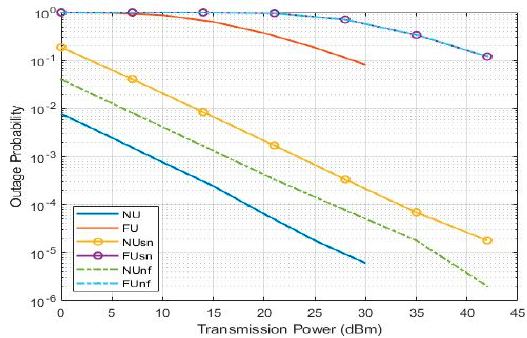
Figure 11. Outage probability vs. transmit power.